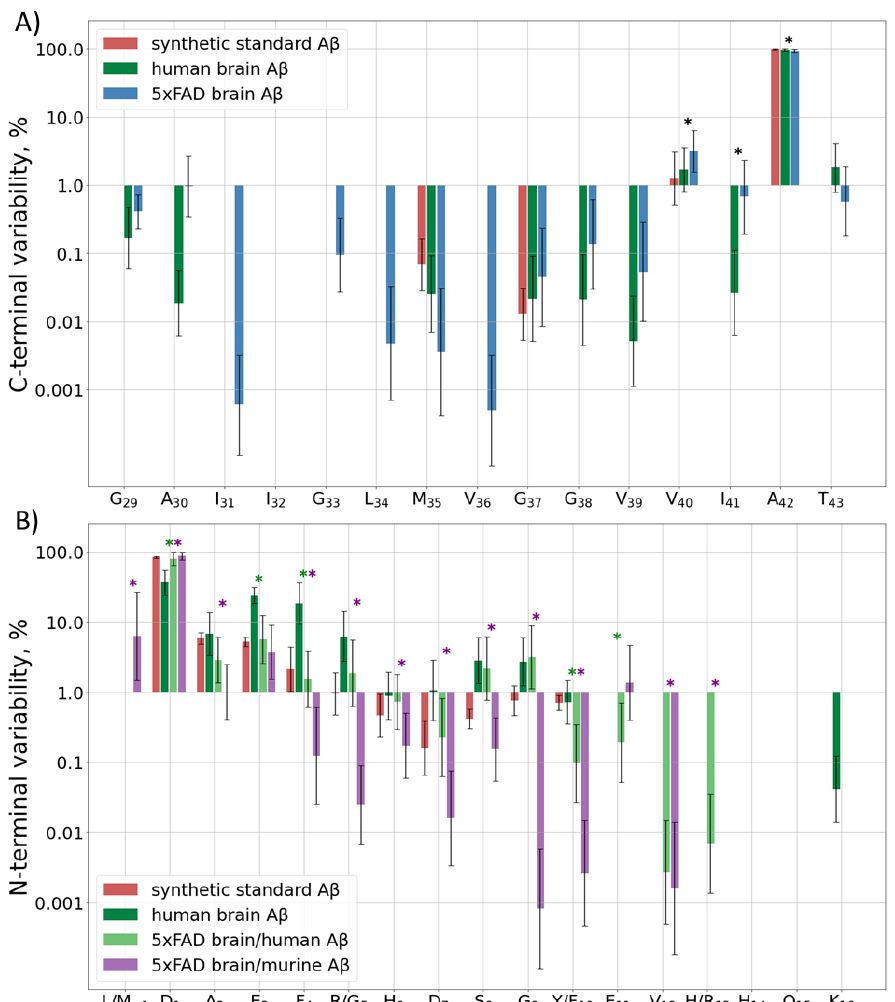
Figure 2. ( A ) C-terminal and ( B ) N-terminal variability of detected A β forms. Input of various A β forms ending ( A ) or starting ( B ) at each position of the sequence indicated at the horizontal axis to the total intensity of the corresponding terminal peptides for the synthetic standard, human, and murine peptide extracts from 5xFAD mice or the human AD sample. Mean values ± SD are shown, significant differences ( p < 0.05) between human A β from the human and 5xFAD brain samples and between human and murine A β , both from the 5xFAD samples, are marked with green and purple asterisks (*), respectively. p -values for statistically significant/insignificant differences between groups are shown in Supplementary Table S2H,N.